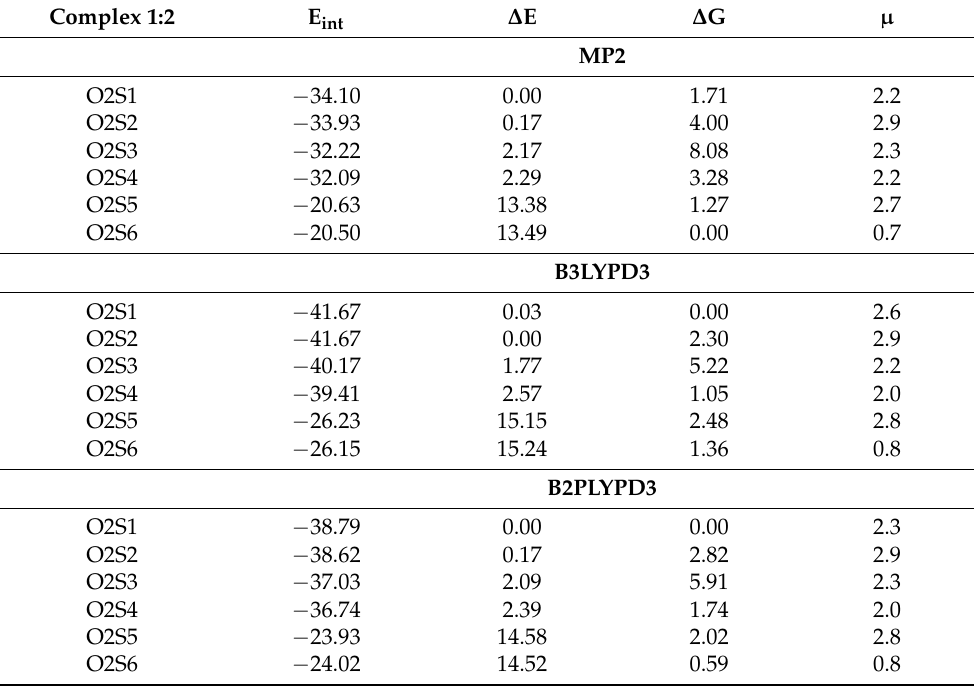
Table 3. BSSE-corrected interaction energies E int , relative energies ∆ E, relative Gibbs free energies ∆ G (kJ mol − 1 ) and dipole moments µ (Debye) of the HNCO · · · SO 2 complexes of the 1:2 stoichiometry calculated at MP2, B3LYPD3 and B2PLYPD3